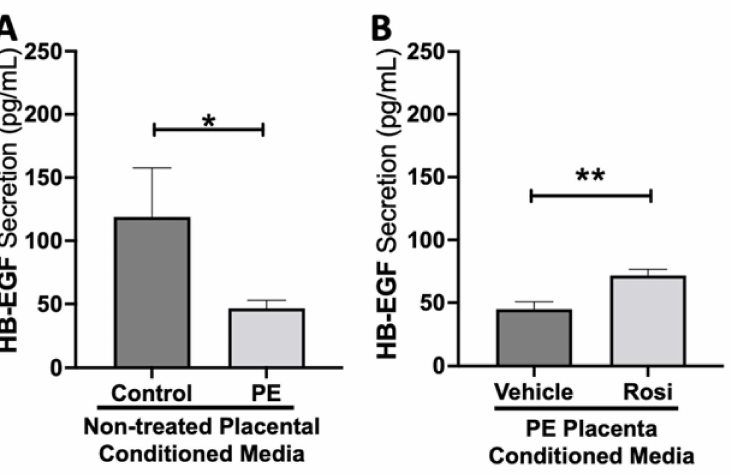
Figure 6. There are no significant changes in Epidermal Growth Factor secretion between healthy and preeclamptic placentas treated with or without Rosiglitazone. Secretion of Epidermal Growth Factor (EGF) was measured via Luminex assay from conditioned media from non-treated control and preeclamptic (PE) placentas ( A ) and vehicle- or Rosiglitazone (Rosi)-treated PE placentas ( B ). There was no significant change in EGF secretion between PE and control placentas ( A , n > 10) and between vehicle and Rosi-treated PE placentas in the PE compared to control placentas however this was not statistically significant ( B , n = 14). (Protein secretion was measured by a Luminex assay where experimental values were determined relative to a standard curve. Statistical analysis was performed by student’s t-test to determine significant differences between groups, bar plots and data reported are reported as mean pg/mL values ± SEM).